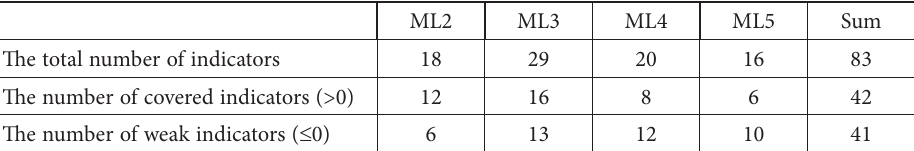
Table 8. Status of CSF indicators and maturity levels within the studied organization ML2 ML3